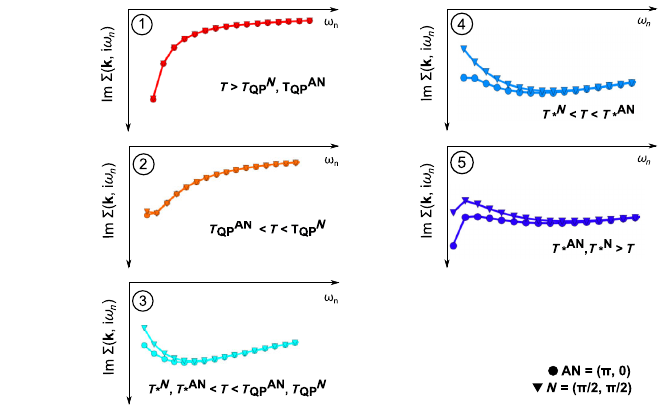
and T N , (cid:4) (cid:4)